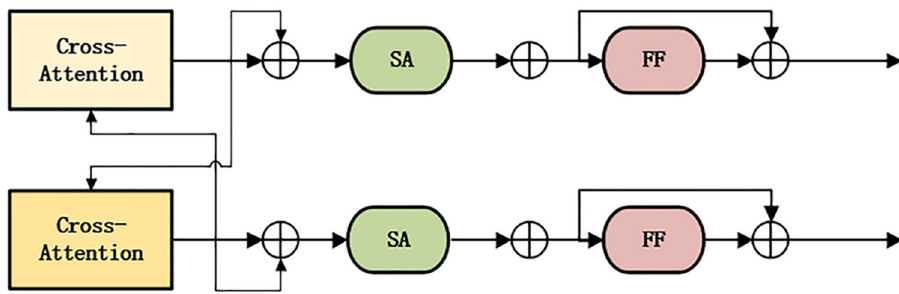
Fig 3. Single Cross-Modality Fusion Encoder